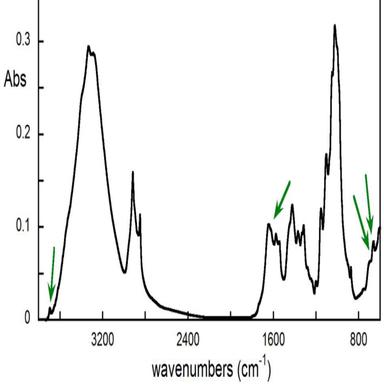
FTIR spectrum of the page 2 of the volume 57. The arrows indicate the bands attributable to oxalates.